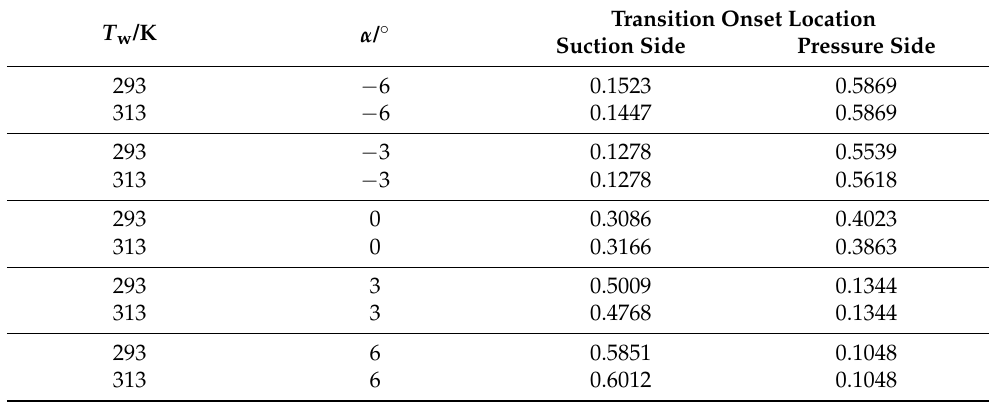
Table A4. Influence of surface temperature on transition onset location ( ε = 0.5%, Ma = 0.7).